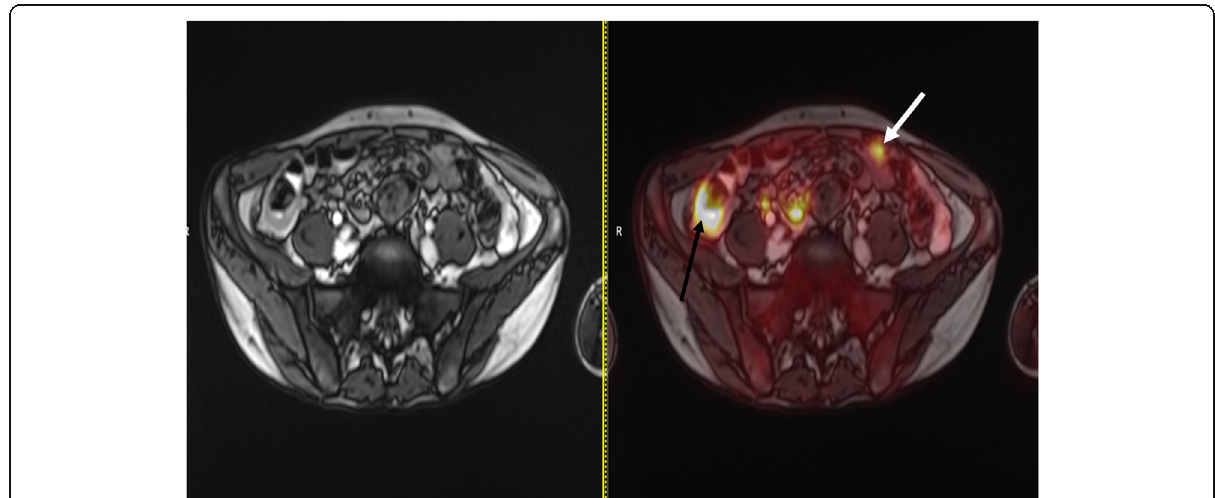
Fig. 4 Hybrid PET/MRI imaging of the abdomen. Multifocal thickening with abnormal FDG uptake noted in the ileal loops in right iliac fossa (black arrows) with associated mesenteric fat stranding and mesenteric lymphadenopathy (white